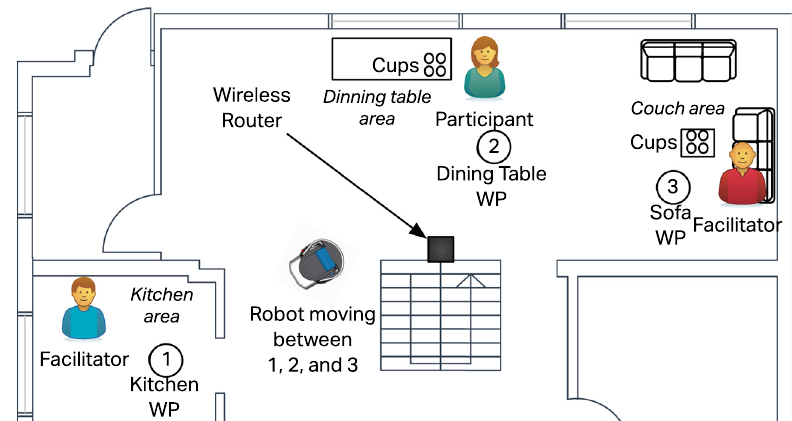
Figure 2: Floor plan and position of people for the experiment. The robot would move between the numbered positions, starting at Position 1, using either a linear or slow in and slow out velocity pro fi